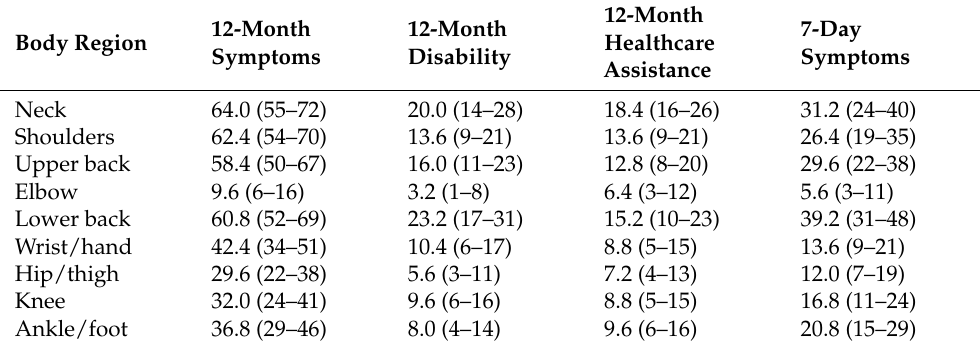
Table 2. The prevalence of musculoskeletal symptoms among healthcare workers of the HEROES cohort at baseline. Data are expressed as % and 95%